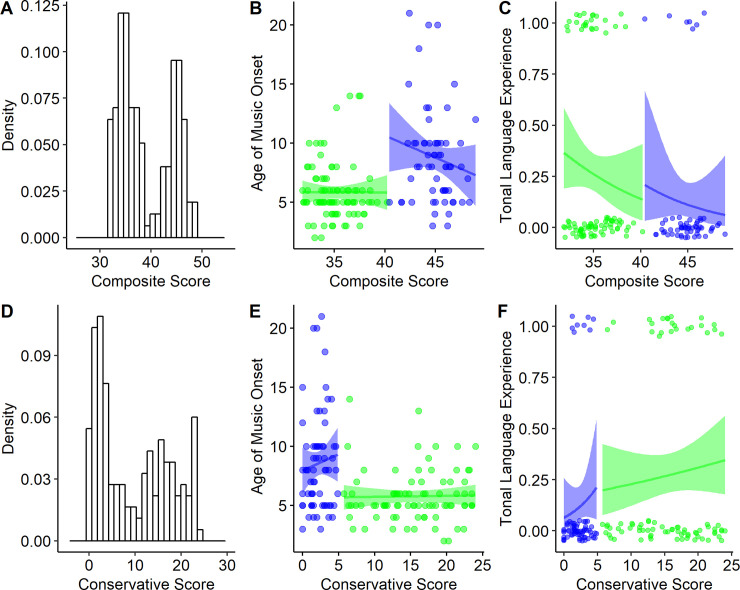
Results from the distributional modelling of AP performance using Gaussian Mixture Models (GMMs).5A: GMM results from the composite score, depicting the best-fit distributions of the high-performing (green) and low-performing (blue) groups, overlaid on a histogram of the AP composite score. 5B: Age of musical training onset plotted against composite score; points are colored according to the distribution they are more likely to belong to (posterior probability > 0.5), and lines of best fit are shown for each distribution. The line is virtually flat for the high performing distribution, suggesting that age of beginning musical training does little to differentiate gradations of pitch-labeling ability, consistent with the results shown in Fig 2. 5C: Tonal language experience vs. composite score; logistic best fit, representing the probability of speaking a tonal language given the composite score, is shown for each distribution. 5D-F: The same plots as 5A-C but using the more conservative operationalization of AP instead of composite score.